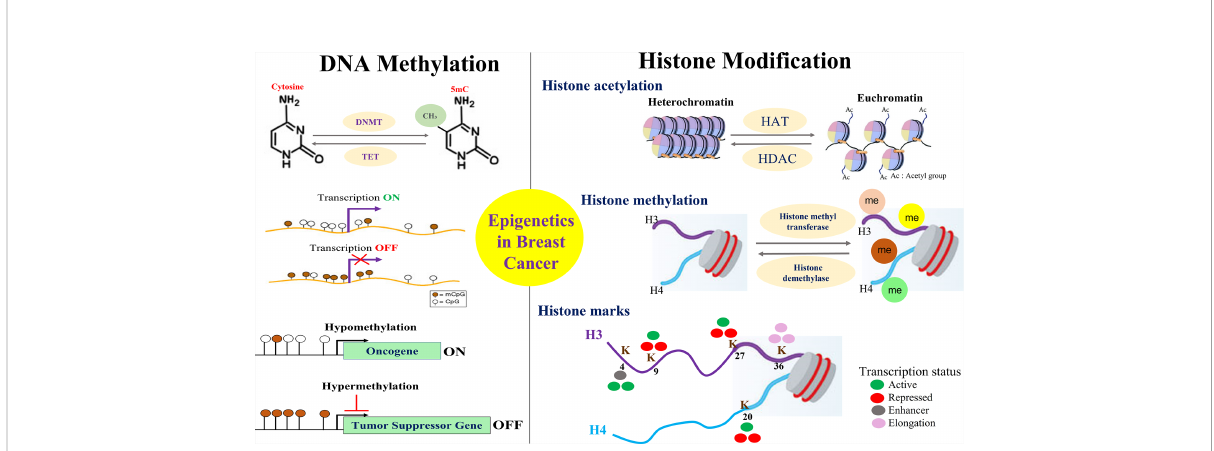
FIGURE 2 Overview of Key Epigenetic Events in Breast Cancer. Mechanisms for epigenetic alterations in breast cancer are shown focusing on two major players that include the methylation of DNA and the modi fi cation of histone proteins. Hypomethylation of oncogenes and hypermethylation of tumor suppressor genes is an important epigenetic phenomenon in breast cancer that affects various cellular processes of proliferation, apoptosis, migration, invasion, drug resistance, etc. Post translation modi fi cations made to histone proteins impact gene expression by altering the chromatin structure towards open or closed conformation. Histone methylation of lysine is implicated in both transcriptional activation and repression depending on the methylation site that constitutes the various histone marks/code.